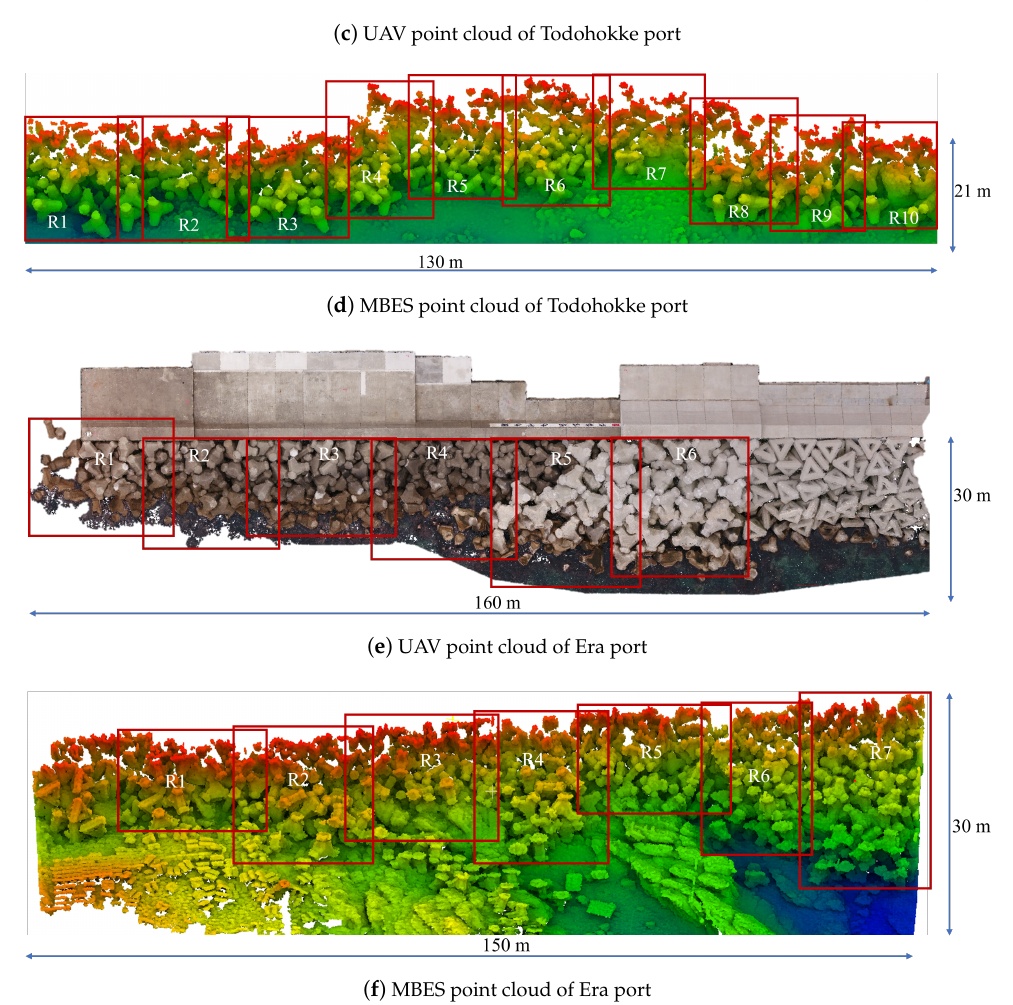
Figure A1. Point cloud of three